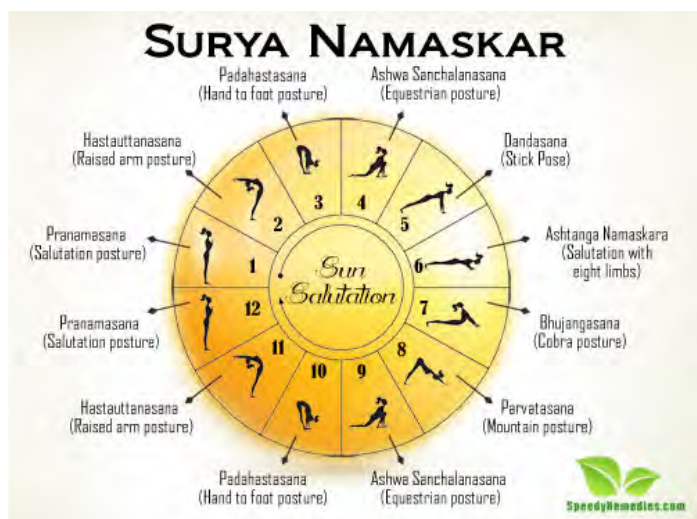
Fig. 1. Surya Namaskar «Salutations to the Sun» complex